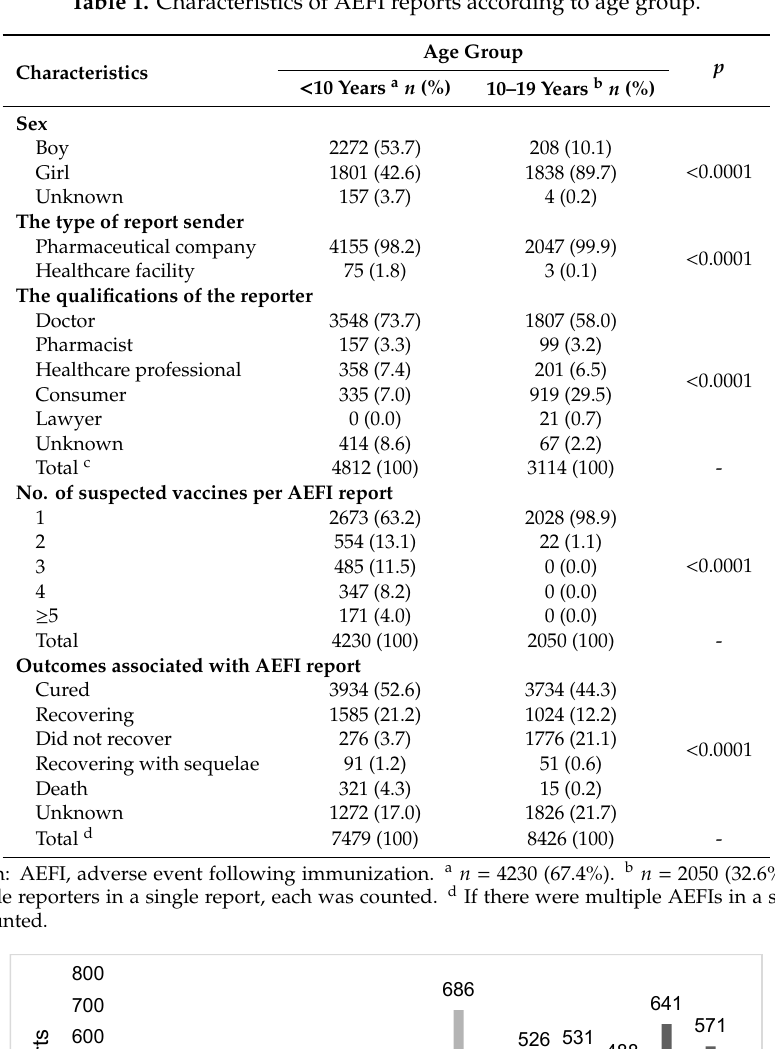
Table 1. Characteristics of AEFI reports according to age group.